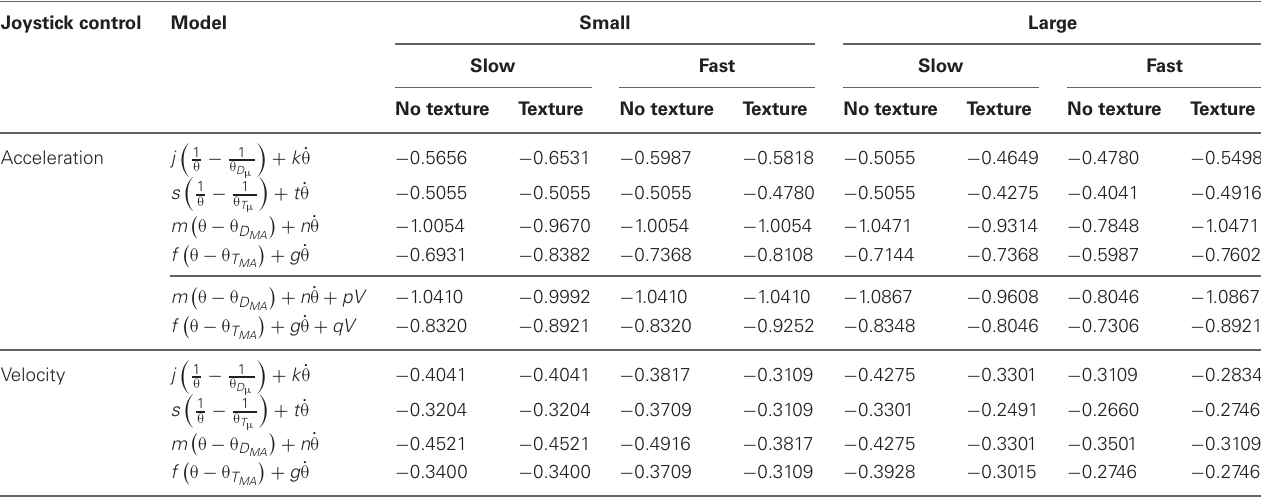
Table 3 | BIC values 1 for the θ D μ , θ T μ , θ D the size of the lead object, its speed, and the presence of ground texture. Joystick control